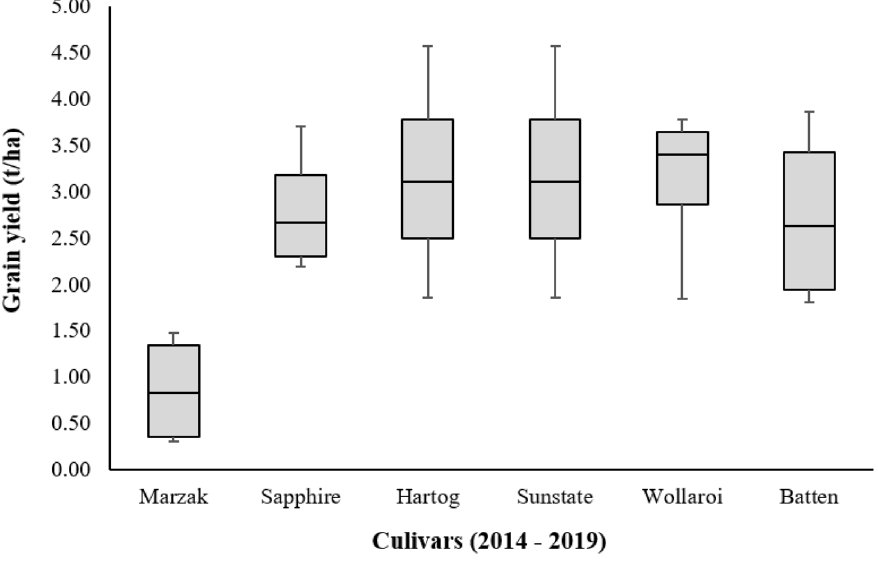
Figure 19. Comparison of several varieties simulated at the same conditions of the study area for the calibrated period (2014–2019).